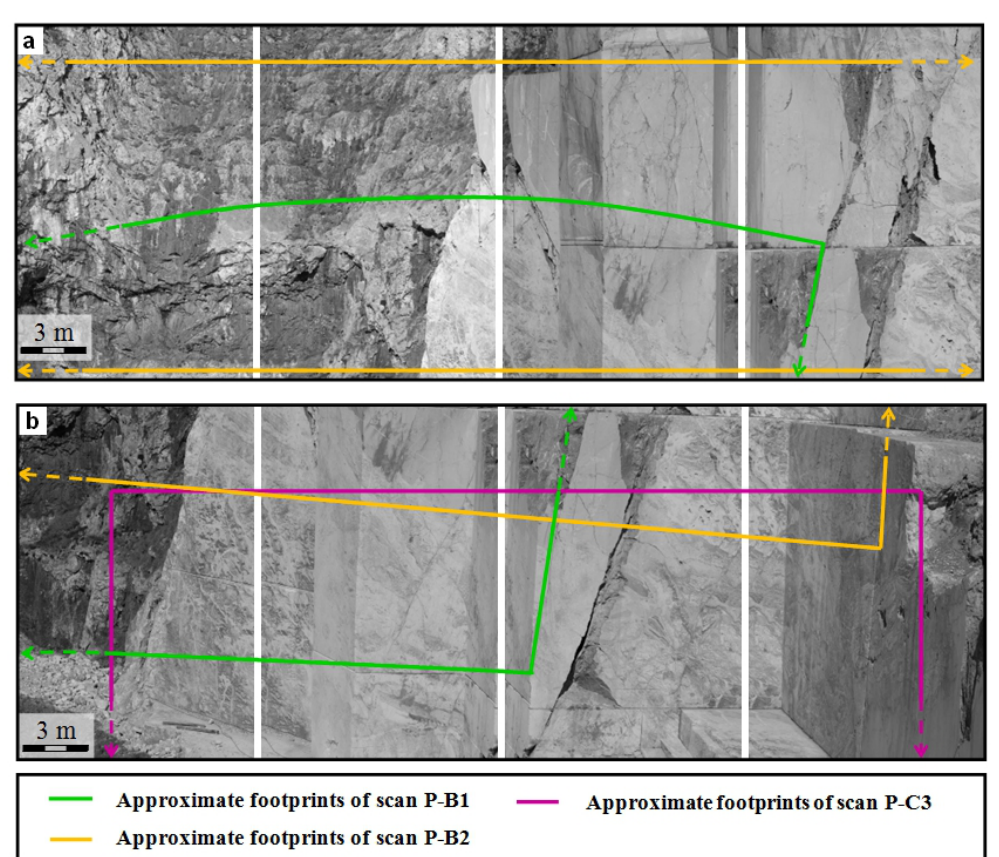
Figure 4. Nikon D200 images covering part of the Pozalagua quarry, converted to grayscale. Arrows indicate extents of SWIR image areas outside of the used VIS images. ( a ) upper and ( b ) lower image strip.